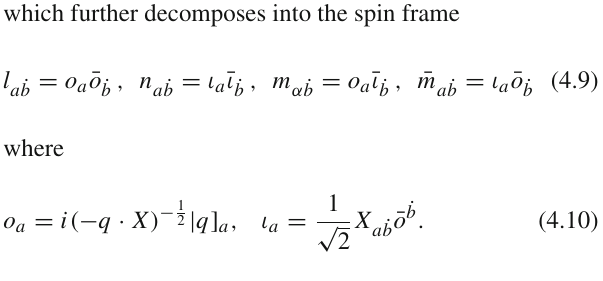
Table 1. Wavefunctions with (cid:2) ∈ C and J ∈ 1